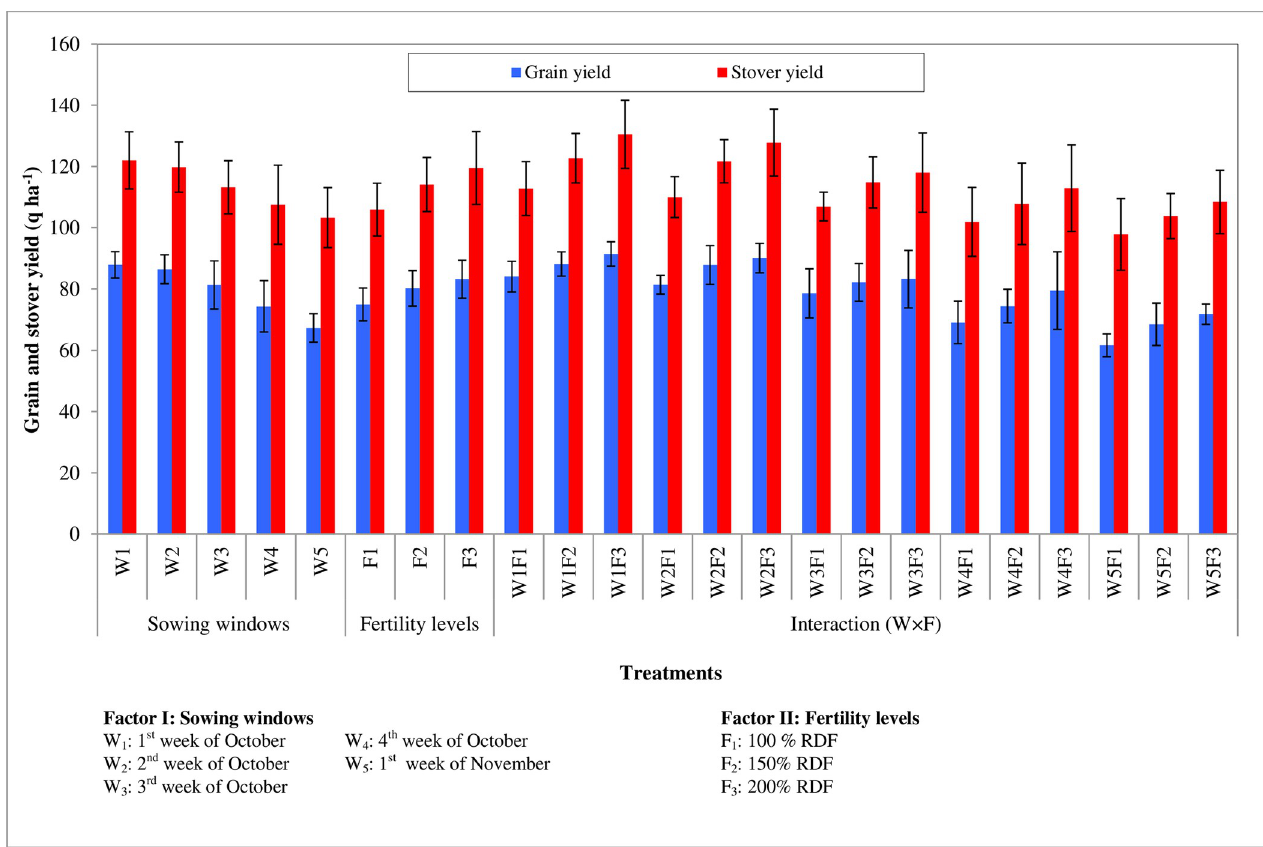
Fig 2. Grain yield and stover yield of winter maize as influenced by sowing windows and fertility levels.